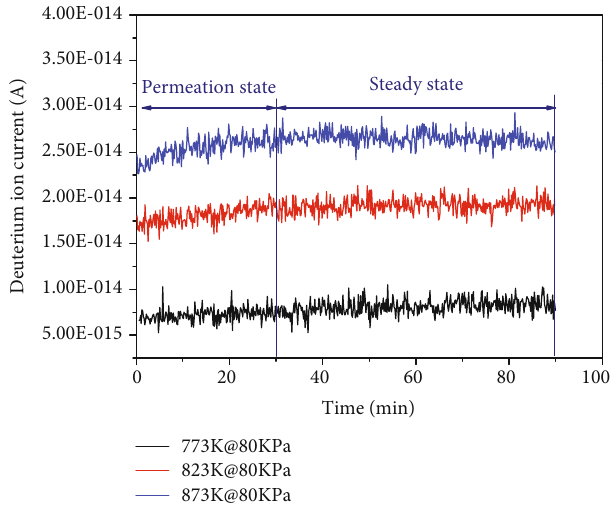
Figure 5: Deuterium ion current of Al/Al permeation temperature.